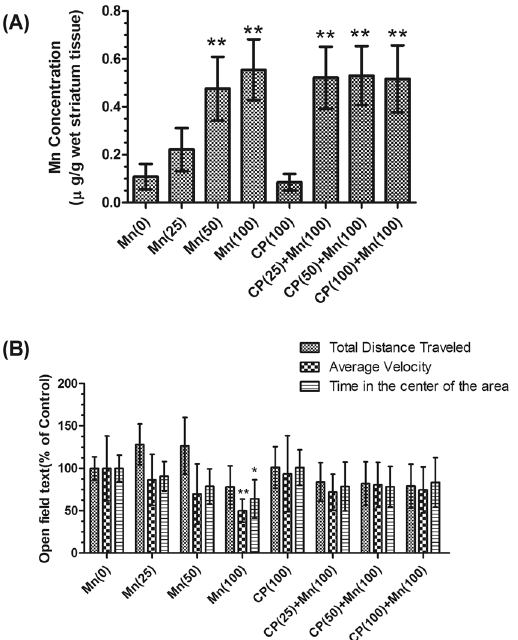
Figure 1. Manganese concentrations of mice basal nuclei and behavioral activity of mice on the 24th day after Mncl 2 -exposed. ( A ) Total Mn levels in basal nuclei of mice. Mice were intraperitoneally (i.p.) treated with physiological saline as control group and MnCl 2 (25, 50, 100 μ mol/kg) as Mncl 2 -exposed groups, subcutaneously (s.c.) pre-treated with 100 μ g/kg calpeptin as calpeptin control group and calpeptin (25, 50, 100 μ g/kg) accompany with 100 μ mol/kg MnCl 2 for 24 days, and 24 h after treatment was finished the basal nuclei were isolated. ( B ) Behavior in an open field test on the 24th day after Mncl 2 -exposed. Mice were placed in the center of the area for 2 min to acclimatization then recorded for 5 min. The total distance traveled, average velocity and time in the inner central zone were measured respectively. The values are expressed as means ± S.D., n = 6. * P < 0.05 and ** P < 0.01significantly different form control group; # P < 0.05, significantly different form 100 μ mol/kg MnCl 2 -treated